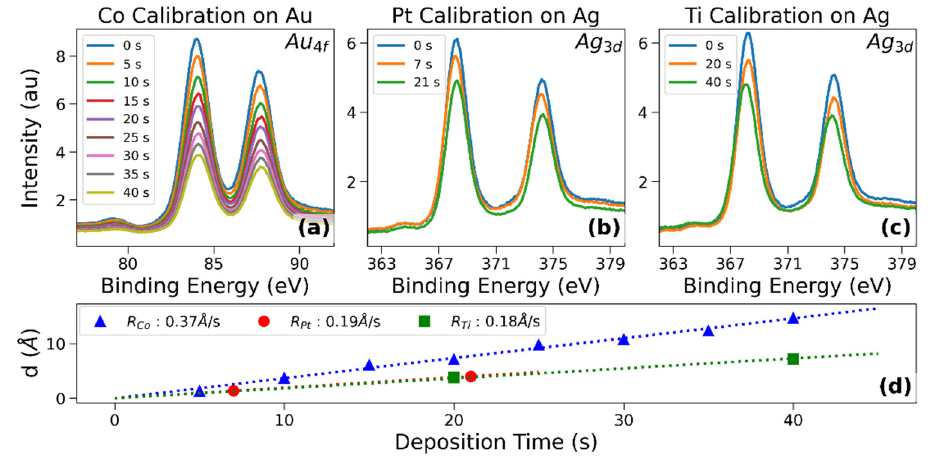
Figure A1. X-ray photoemission spectra of Au4f and Ag3d used for calibration of Co ( a ), Pt ( b ), and Ti ( c ) depositions. Thickness-deposition time graph and deposition rates for Co, Pt, and Ti targets ( d ).